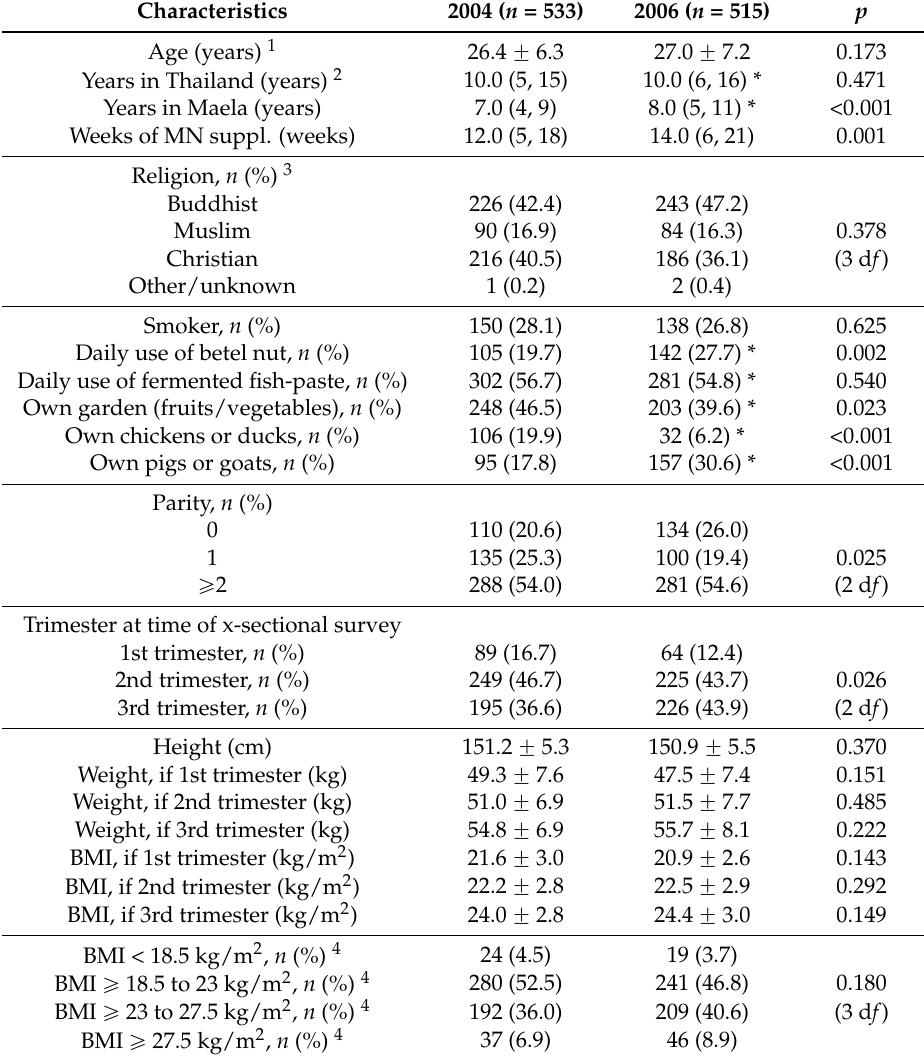
Table 1. Demographics of pregnant women at the time of the cross-sectional